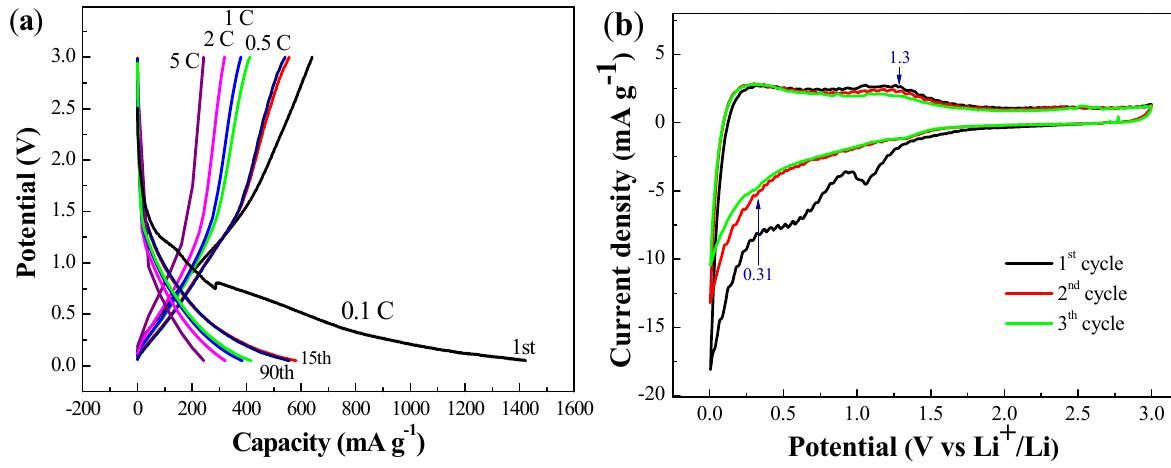
Figure 5. ( a ) Galvanostatic discharge-charge profiles under various C -rate from 0.1 C to 5 C ; and ( b ) cyclic voltammograms in the potential window of 0.01–3 V ( vs. Li + /Li) at a scan rate of 0.1 mV·s − 1 of OMCS 11 .